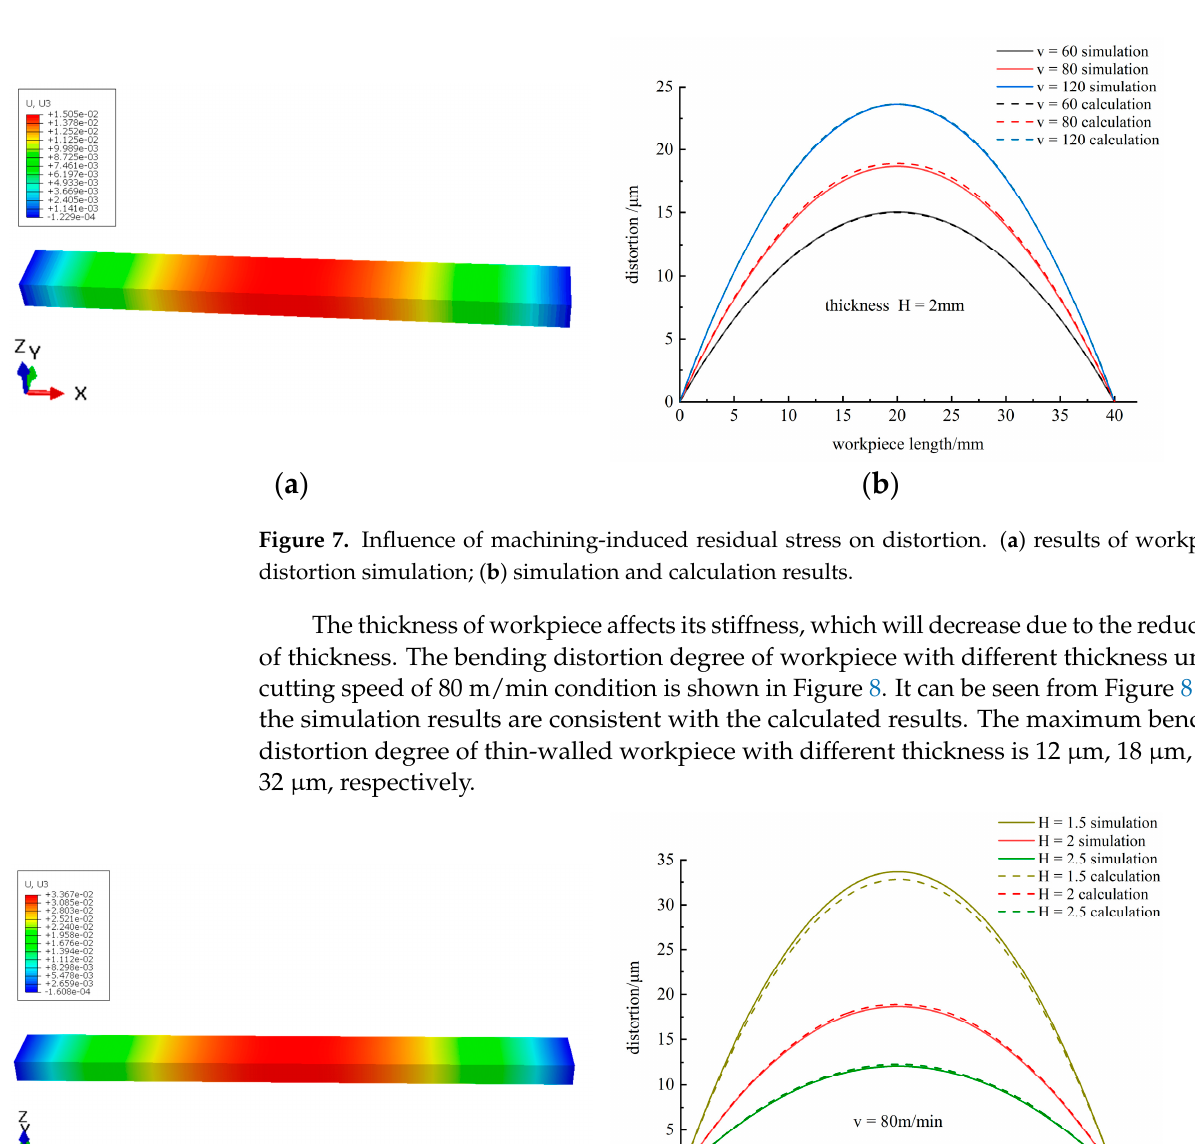
Figure 7. Influence of machining-induced residual stress on distortion. ( a ) results of workpiece distortion simulation; ( b ) simulation and calculation results.